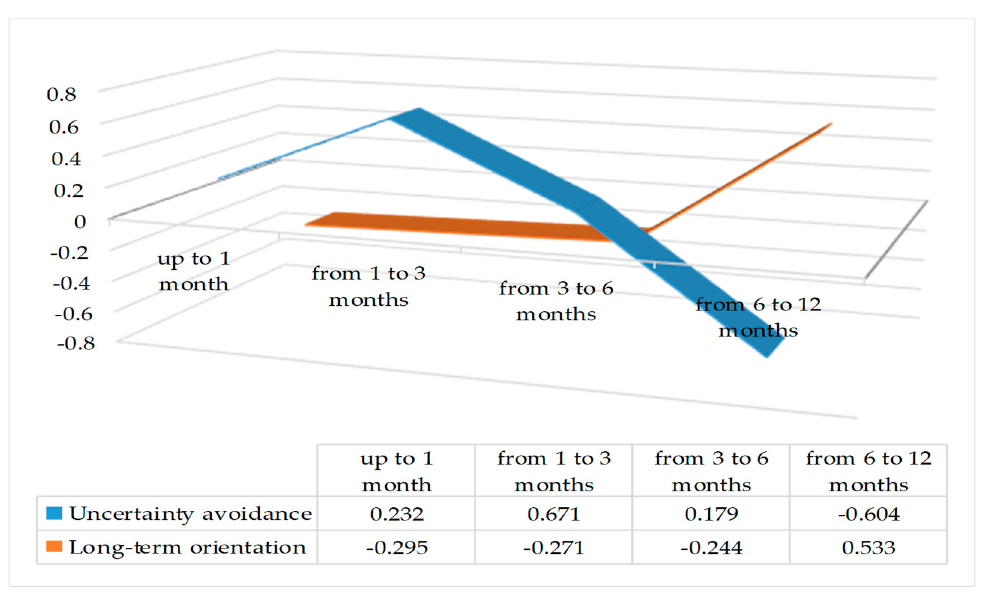
Figure 2. Diagram of correlation relationship between the length of stay, the uncertainty avoidance index, and the long-term orientation of labour migrants from Ukraine. Source: developed by the author based on (Migration Profile of Ukraine 2011–2015).